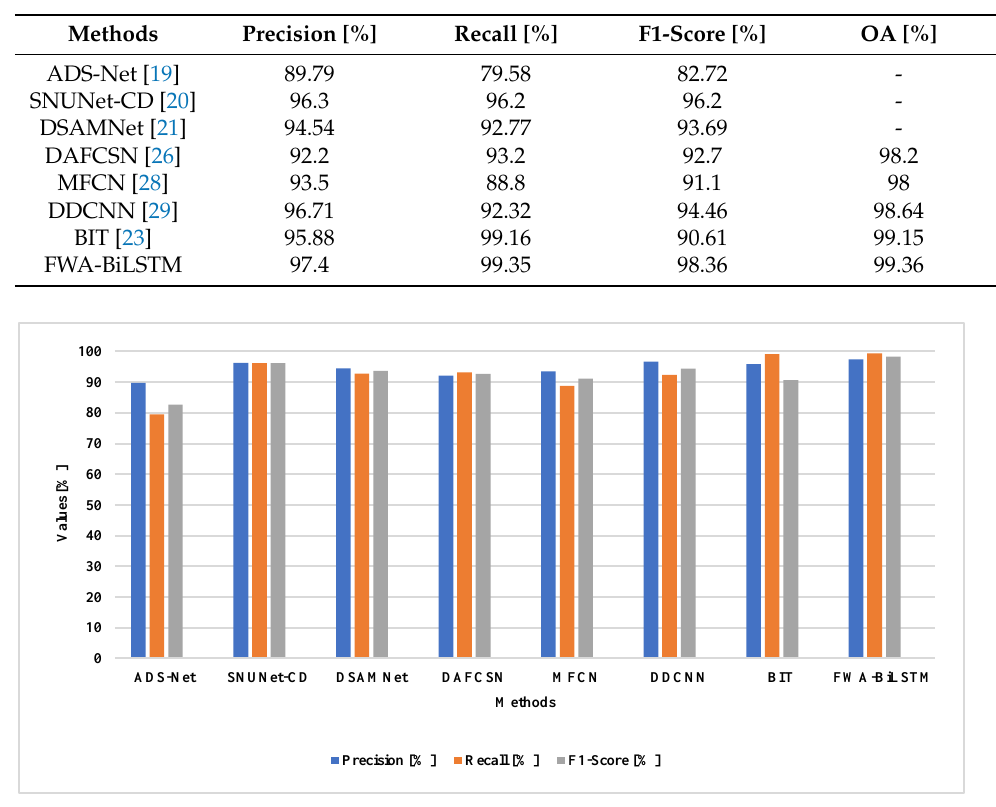
Figure 14. Reference sample image.